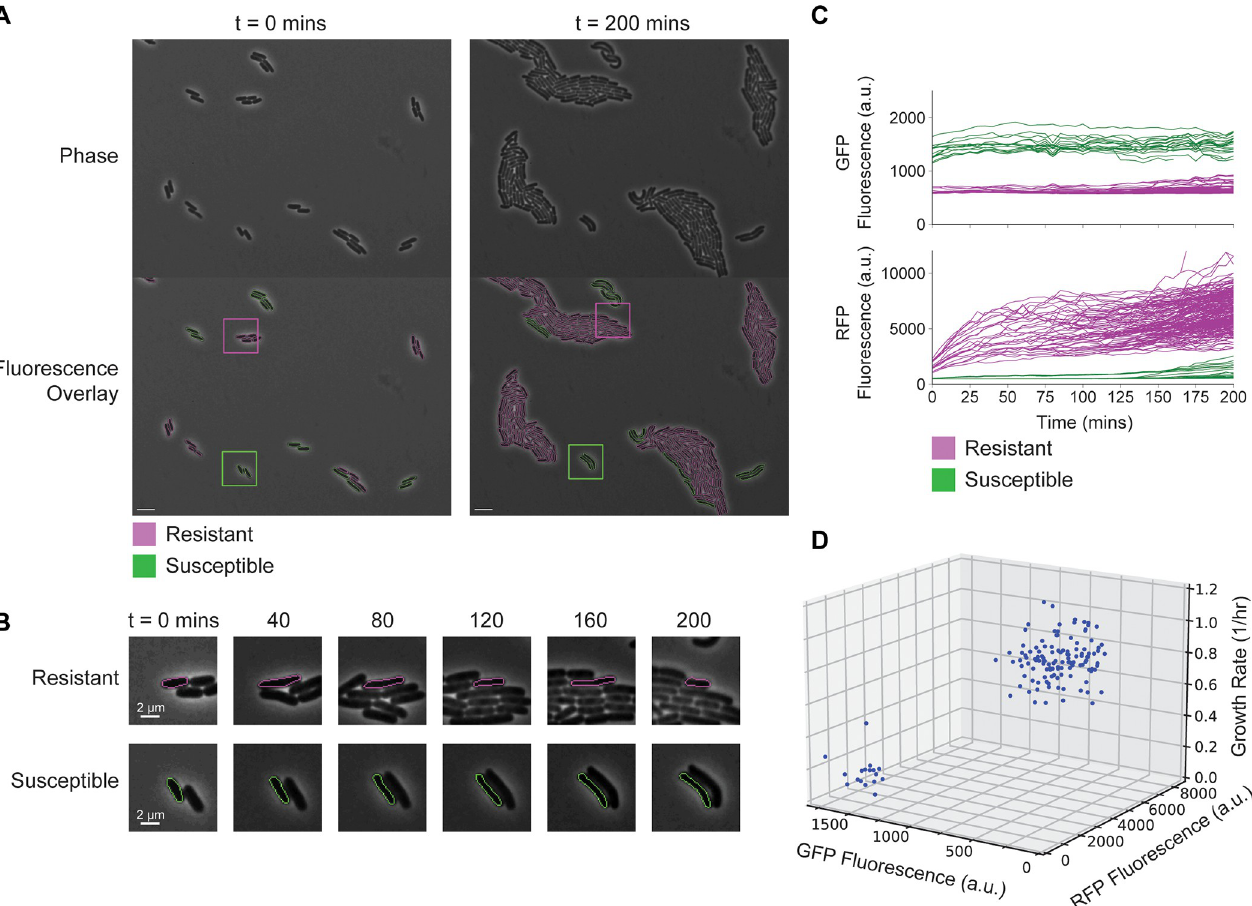
Fig 2. Resistant and susceptible strains of E . coli on agarose pads containing an inhibitory concentration of tetracycline. (A) Phase contrast images and associated fluorescence overlays. RFP expressing cells contain a tetracycline resistance gene and GFP expressing cells do not. The magenta and green cell outlines in the fluorescence overlay represent the resistant and susceptible cells, respectively. Region of interest boxes show the areas represented in (B). (B) Representative examples of antibiotic resistant and susceptible cells tracked over time. (C) RFP and GFP fluorescence tracked for individual cells over time. (D) GFP fluorescence versus RFP fluorescence for single cells plotted against growth rate. Fluorescence values are the averages over all the frames for that cell. For growth rate calculations, only cells that were present at t = 150 min were tracked, which is a time point mid-to-late in the movie. The analysis omits those cells that enter the field of view after t = 150 min since the growth rates become noisier with less data. Three resistant cell outliers with growth rates of ~1.4 1/hr are omitted from this